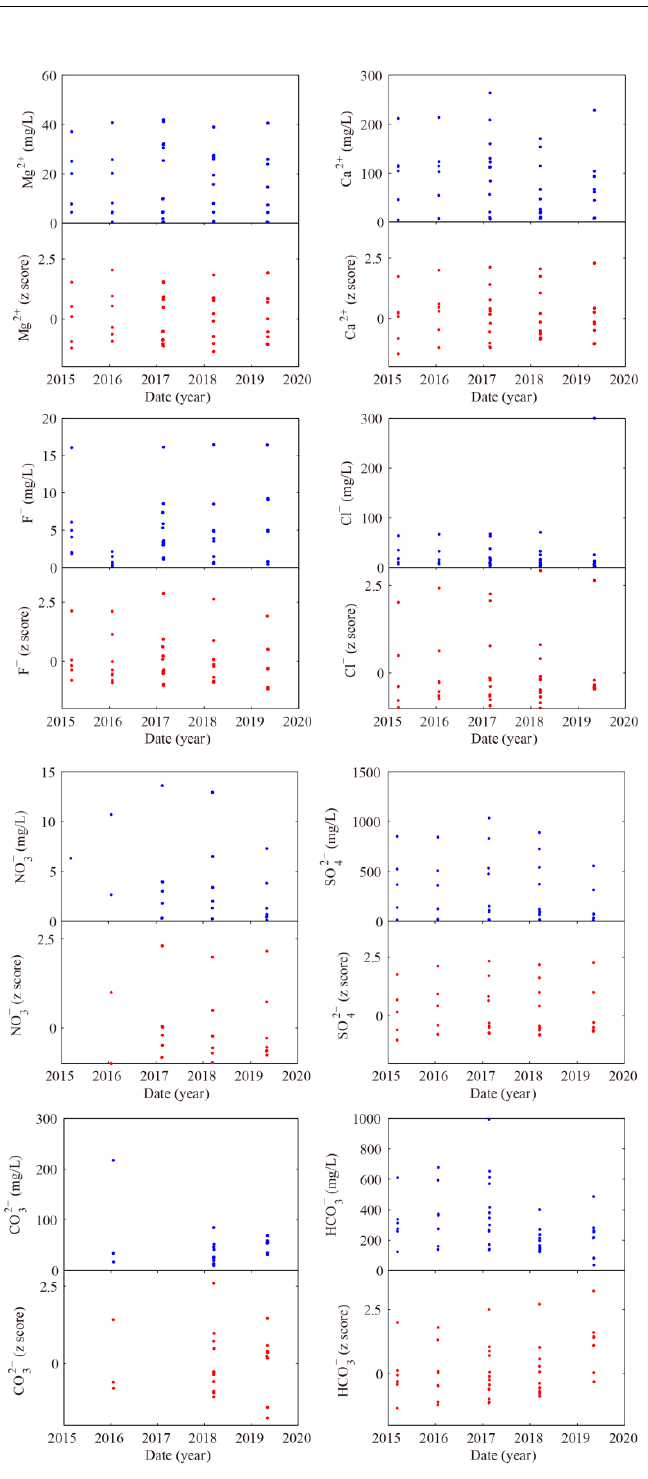
Figure 2. Time trend (dates indicated as yyyy) of the absolute values (in mg/L) and of the z scores of the variables Na + , K + , Ca 2+ , Mg 2+ , F − , Cl − , NO 3 − , CO 32 − , SO 42 − , and HCO 3 − from